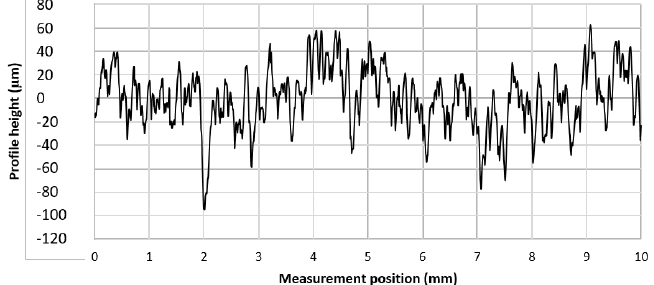
Figure 2. Profilometry measurement of an untreated selective laser sintered (SLS) substrate.